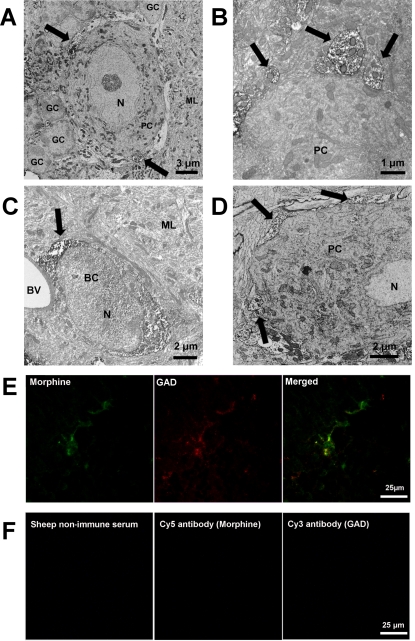
Characterization of morphine immunoreactivity in the mouse cerebellum.
A. Characterization of morphine immunolabelling around Purkinje cells. Electron microscopy using sheep anti-morphine antibody showed morphine-like immunoreactivity in nerve termini innervating Purkinje cell bodies (PC). Arrows indicate strong immunolabelling of morphine-containing termini around the Purkinje cell body. GC, granular cell. ML, molecular layer, N, nucleus. B. Higher magnification showing the presence of morphine immunoreactivity in nerve termini innervating Purkinje cell bodies. C. Electron microscopy showing morphine immunoreactivity in basket cells (BC). BV, blood vessel. ML, molecular layer. Control experiments using anti-sheep HRP-conjugated IgG showed the specificity of the immunolabelling. D. Electron microscopy showing PEBP-immunoreactivity in nerve termini covering Purkinje cell bodies (PC). Arrows indicate strong immunolabelling of PEBP-containing basket cell termini. E. Evidence of colocalization of morphine and glutamic acid decarboxylase (GAD). Double immunofluorescence confocal micrographs were obtained using a sheep anti-morphine antibody (detected with a CY5-conjugated IgG, green pseudocolor label) and an antibody against GAD visualized in red with a Cy3-conjugated IgG. Colocalized immunolabelling (arrows and merged window) appears as yellow staining. F. Control experiments were performed using sheep non-immune serum, or only secondary antibodies detected with Cy5- and Cy3-conjugated IgG (primary antibody omitted), to demonstrate the specificity of the immunolabelling.